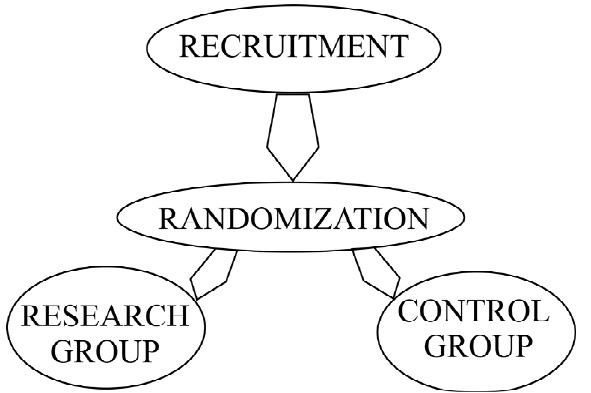
Figure 1. Research design.